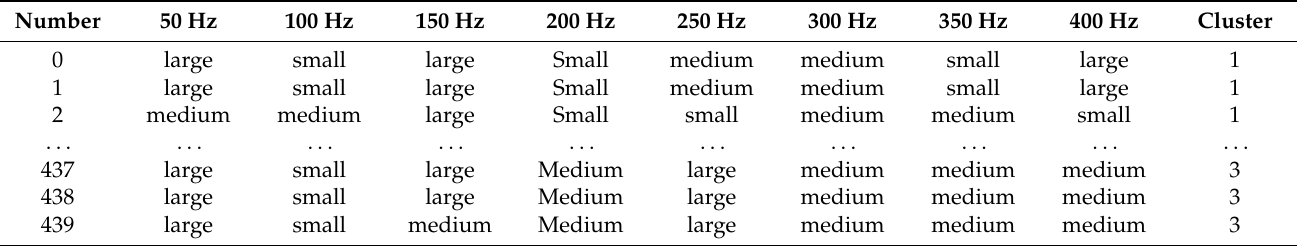
Table 1. Spectrum attribute data